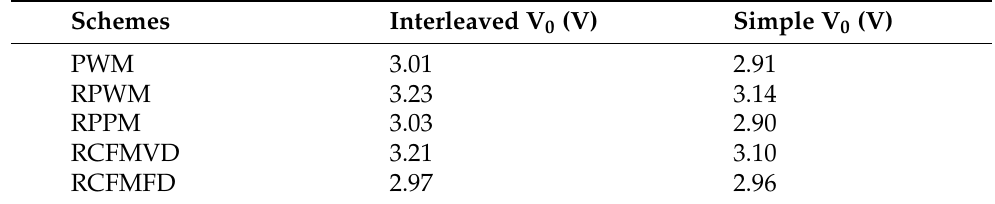
Table 4. The impact of different switching schemes on output voltage variations for simple and interleaved